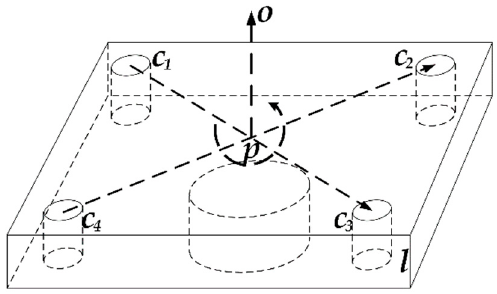
Figure 11. Measurement auxiliary tool.